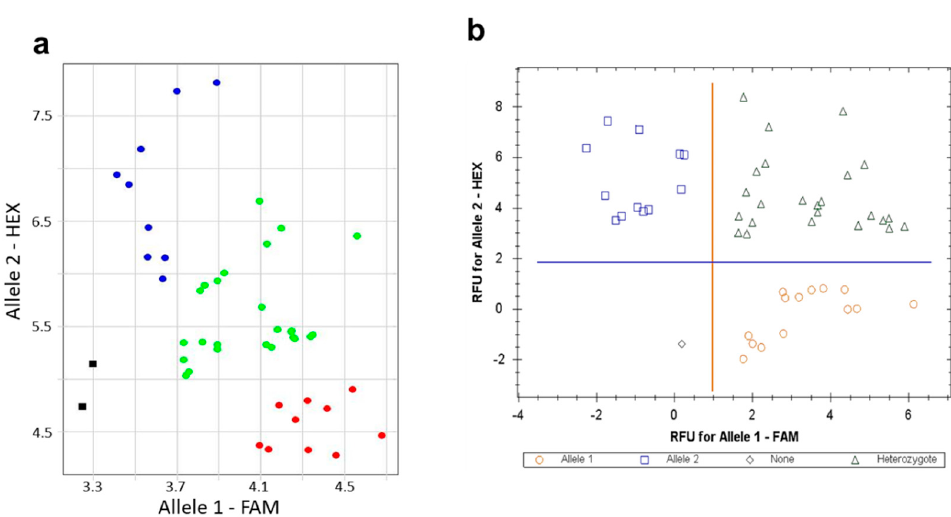
Figure 3. Allele discrimination scores based on SNPs in HvSAP8 for genotyping of the hybrid population Granal × Baisheshek ( a ) and in HvSAP16 for genotyping of the hybrid population Natali × Auksiniai-2 ( b ). Relative fluorescence units (RFU) for fluorophores FAM and HEX were transformed automatically into genotyping of alleles 1 and 2, respectively, using a Thermo Fisher Scientific QuantStudio-7 Real-Time PCR instrument ( a ) and a Bio-Rad CFX96 Real-Time PCR instrument ( b ). Homozygotes for allele 1 (FAM) are designated by red dots and red circles; homozygotes for allele 2 (HEX) are shown in blue dots and blue squares; green dots and green triangles represent heterozygotes. Numbers of studied plants were n = 42 and n = 50, for Granal × Baisheshek and Natali × Auksiniai-2 hybrid populations, respectively. The normalisation was made by the qPCR software with the comparison of fluorescence data to No-template control (NTC, sterile water) shown as black squares in the Thermo Fisher Scientific instrument only.